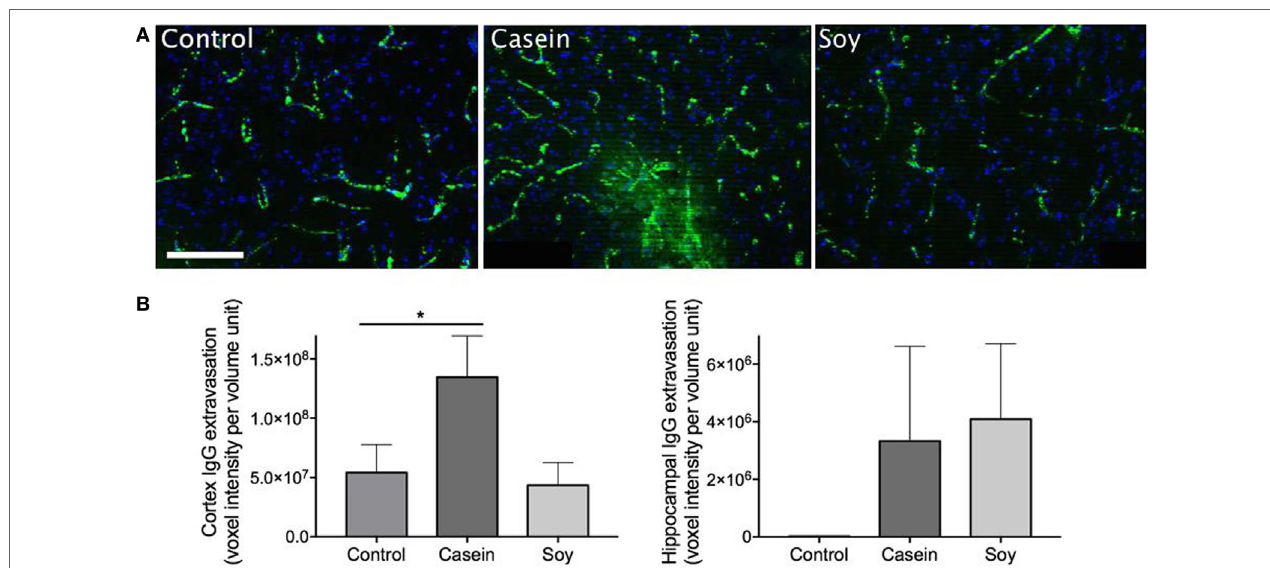
FigUre 1 | Semiquantitative analyses of cerebral parenchymal immunoglobulin g (IgG) extravasation. Cerebral capillary integrity was assessed via immunofluorescent detection of the plasma protein IgG within the cerebral parenchyma in mice maintained on control chow, high-casein diet, or high-soy protein diet. (a) The micrographs show the representative images of peri-vascular IgG (green) in cortex region with DAPI counterstaining of cell nuclei (blue). Scale bar = 100 µm. (B) Semiquantitative analysis of IgG extravasation in cerebral cortex and hippocampal formation is shown. The statistical significance is indicated with * at p < 0.05 (Mann–Whitney test, n = 10). Data shown as mean ±